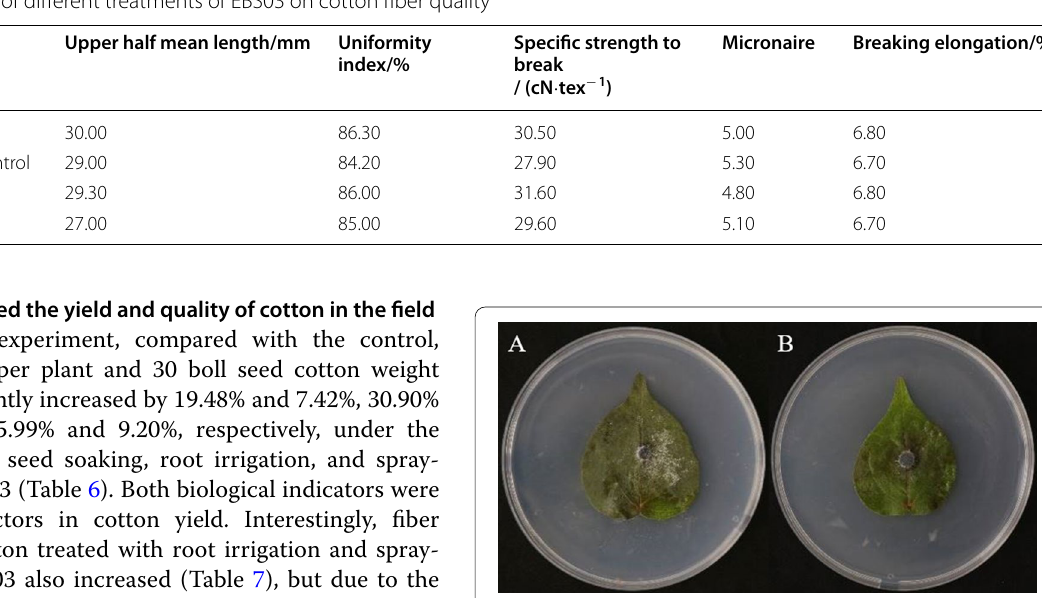
Fig. 5 EBS03 enhanced cotton leaves against V. dahliae . A control; B treated with